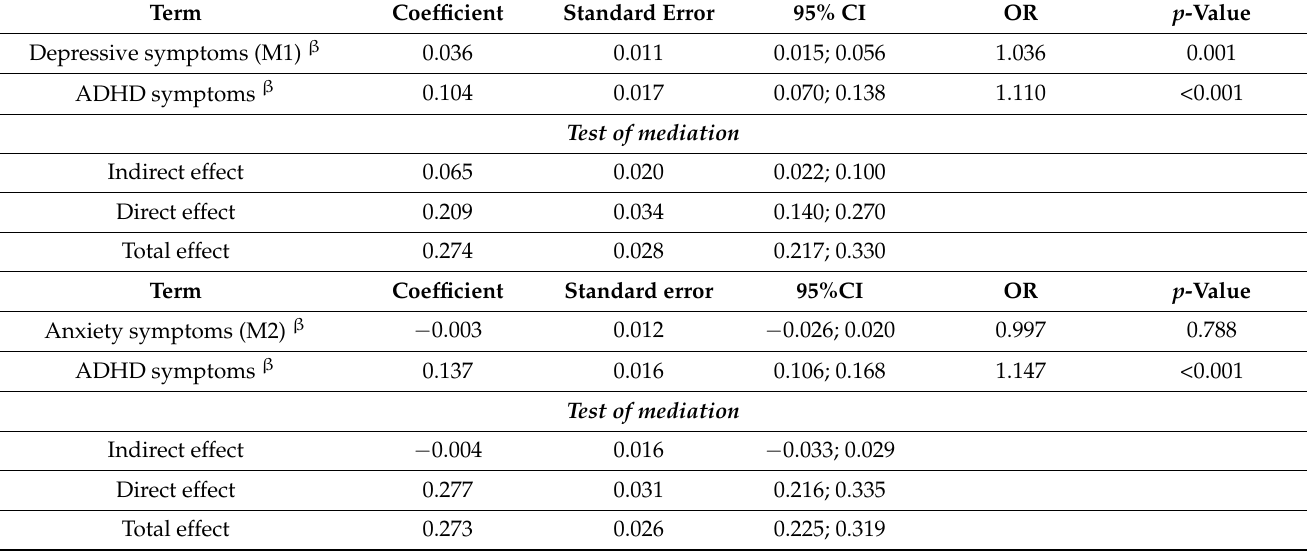
Table 2. A test of the mediation between ADHD symptoms and the academic performance indicator (being on track vs. not being on track with exams): depressive and anxiety symptoms, as assessed by PHQ-9 and GAD-7, respectively